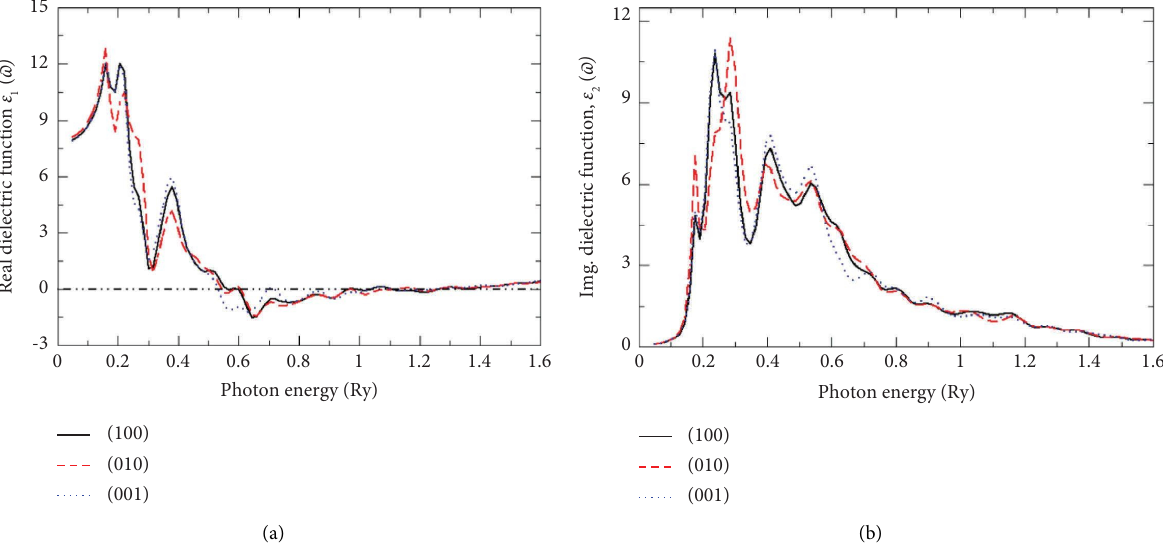
Figure 8: Te real (a) and imaginary (b) part of dielectric function of CaHfS